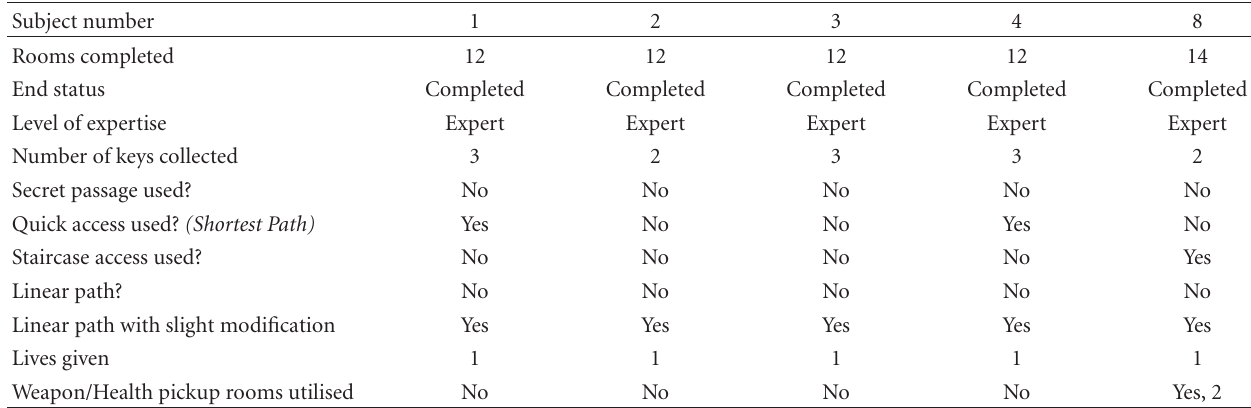
Table 3: The performance of the five best players.